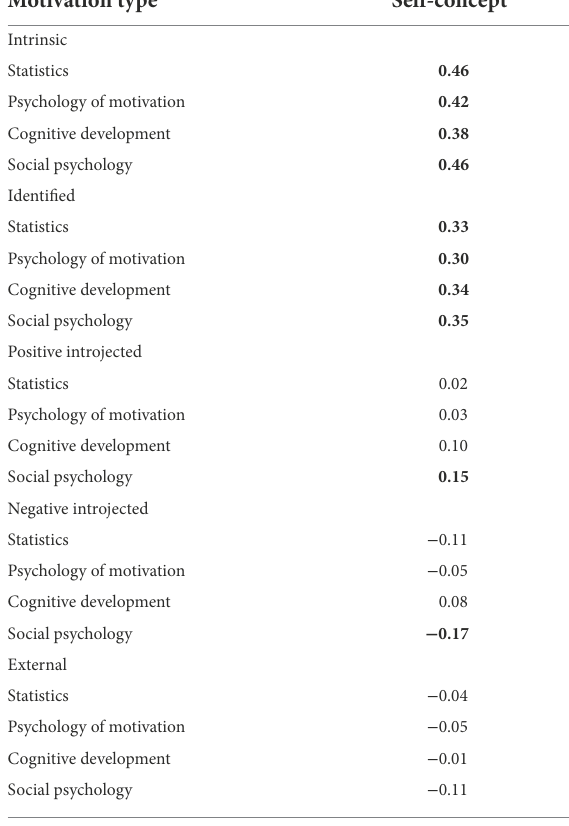
TABLE 6 Correlations between self-concept and motivation types in corresponding courses ( n =